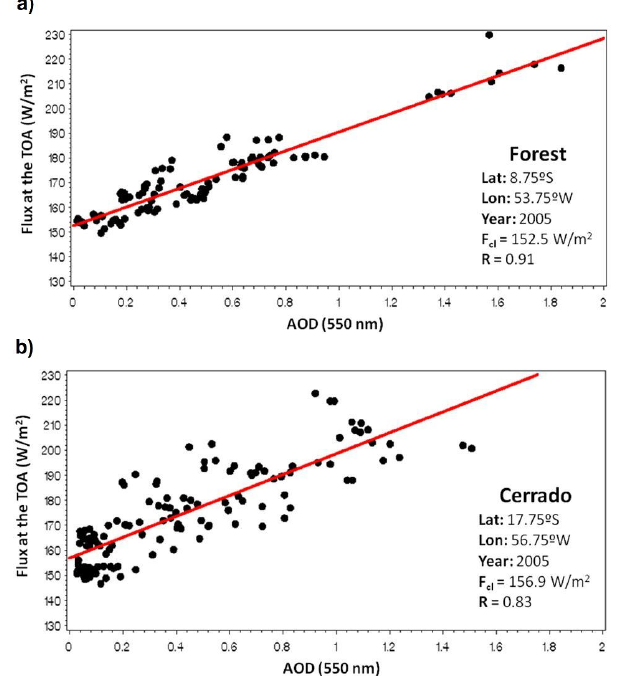
Fig. 4. Examples of the linear fit of CERES flux at the TOA versus MODIS AOD at 550nm for two 0.5 ◦ × 0.5 ◦ cells located at areas covered by (a) forest and (b) cerrado. The larger surface albedo vari- ation within a single cell induces higher data dispersion for cerrado than for forest